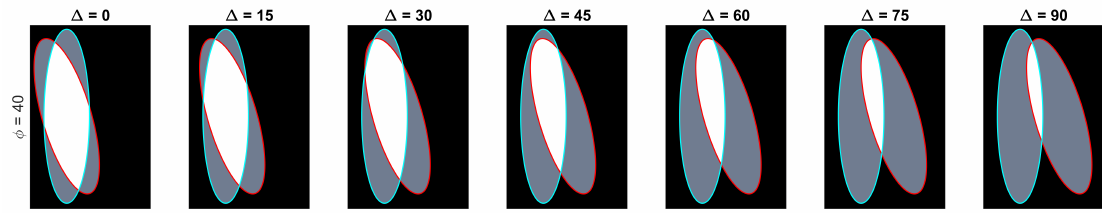
Figure 3. Overview of the range of paired ellipses investigated. The pairs presented on this image represent a small sample of the ellipses that were tested by the method presented. The overlapped region can be seen in white and the areas that are not overlapping are shown in grey. The boundary of the central ellipse is highlighted in cyan while the second ellipse’s boundary is presented in E 0